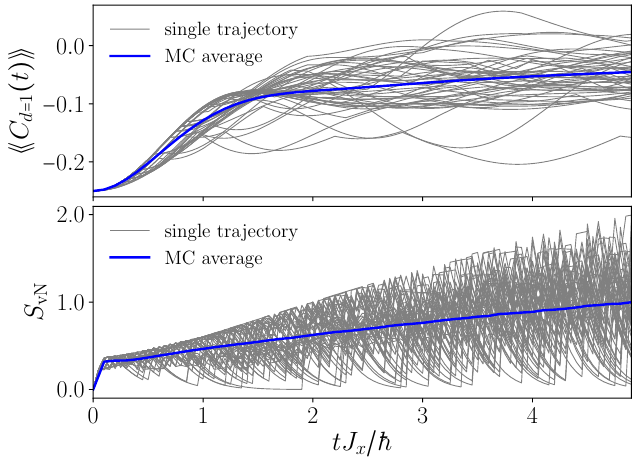
( t ) (top) Figure 5: Dissipative evolution of local equal-time correlation functions C d and the von Neumann entropy S (bottom) of a spin- 1 / 2 chain initially prepared in vN the Neel state under the effect of bulk dephasing D . We show both, the Monte-Carlo 1 average with statistical error bars (not visible, since they are below the line width) and the measured values for a selection of stochastically sampled trajectories for a = 1, spin anisotropy J / J = 1, a chain of length L = 32, dissipation strength (cid:126) γ/ J x z x = 0.05, a truncation goal (cid:34) = 10 − 12 , a maximal bond dimension time step (cid:126) ∆ t / J x D = 100 and 10 4 samples for the MC